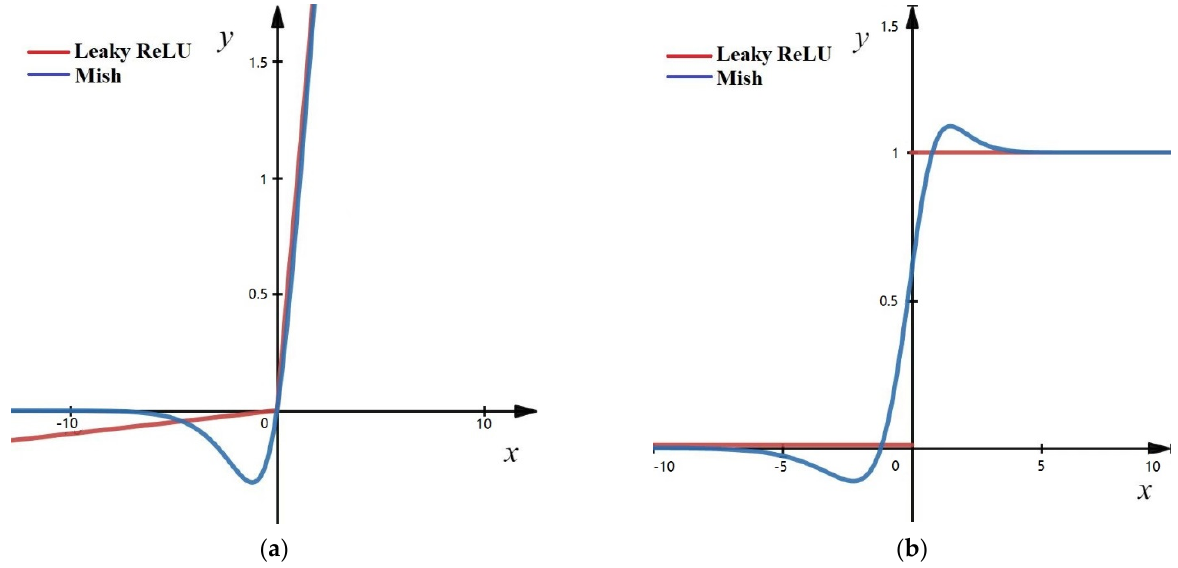
Figure 11. ( a ) Activation function. ( b ) Derivative of the activation function.